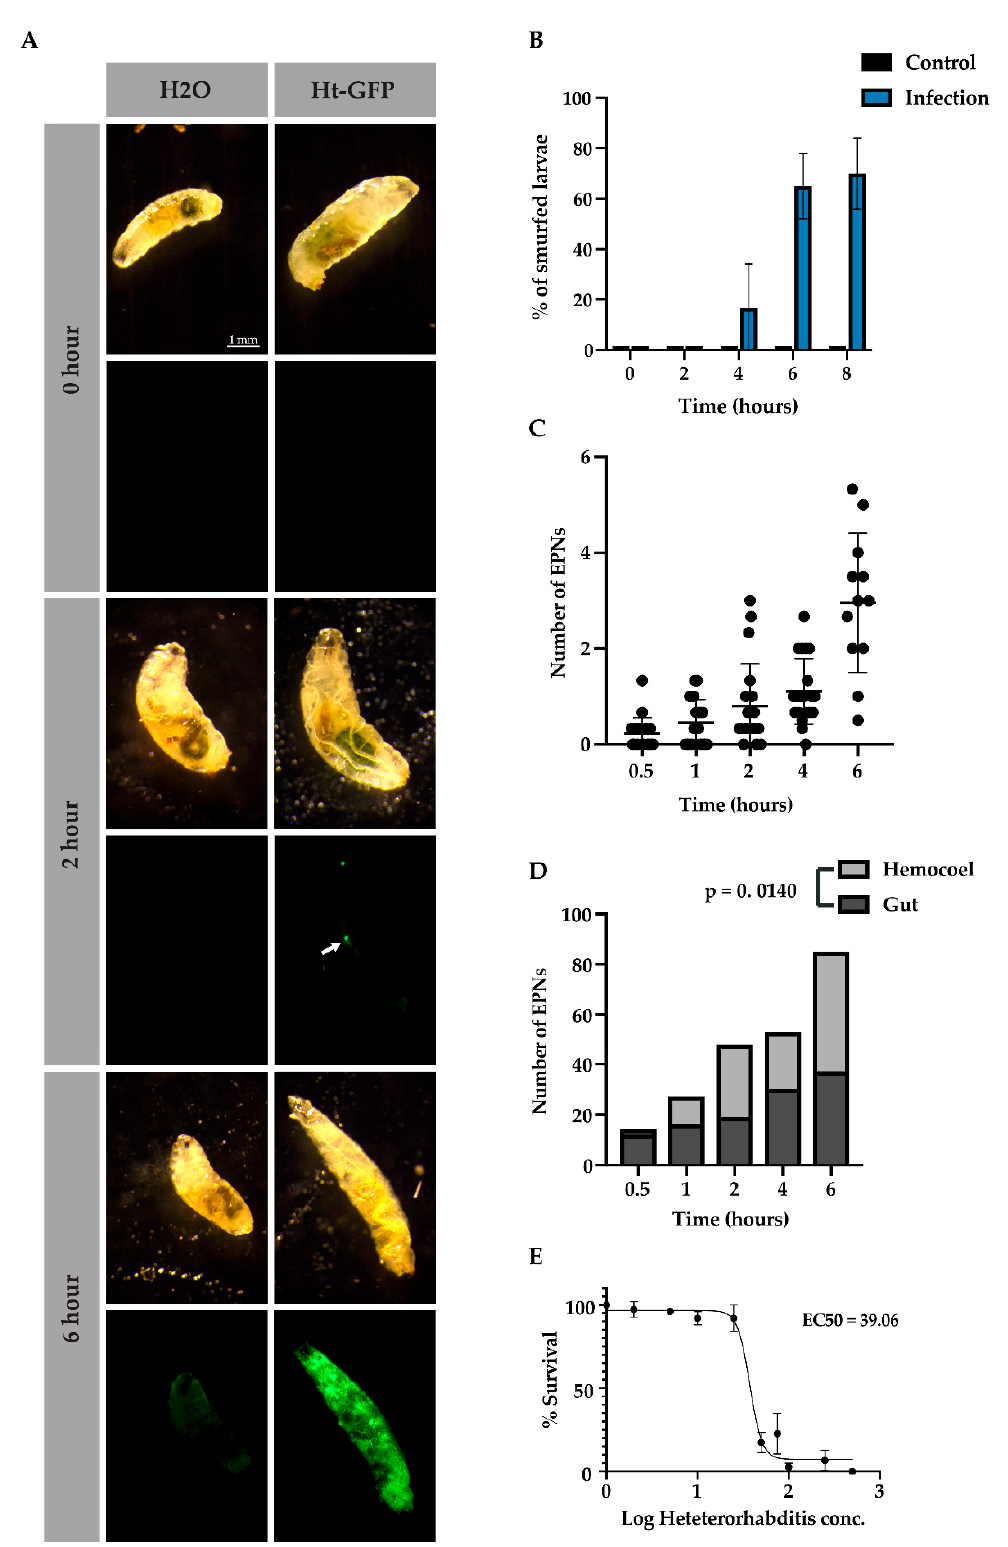
Figure 4. Nematode infectivity and multiplicity of infection in septic animals. Representative images of larvae that were infected with Heterorhabditis (Ht-GFP) or in the control (H 2 O) condition over 0, 2, and 6 h ( A ), scale bars indicate 1 mm. Arrow at the 2-h time point demonstrates a single nematode inside of the host. Infected larvae (Ht-GFP) and control larvae (H 2 O) were scored after 0, 2, 4, 6, and 8 h of EPN exposure to determine the percentage of larvae that had lost tissue integrity and become septic ( B ). The average number of EPNs infecting a single larva over time ( C ). Infected larvae were